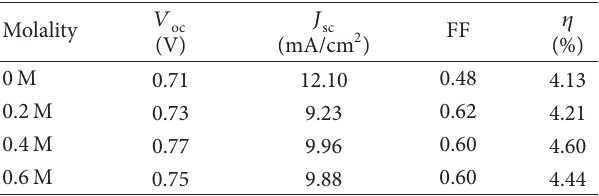
T 2: Photovoltaic parameters of the DSSC based on the composite electrolytes with 1-butyl-3-methylimidazolium iodide at different